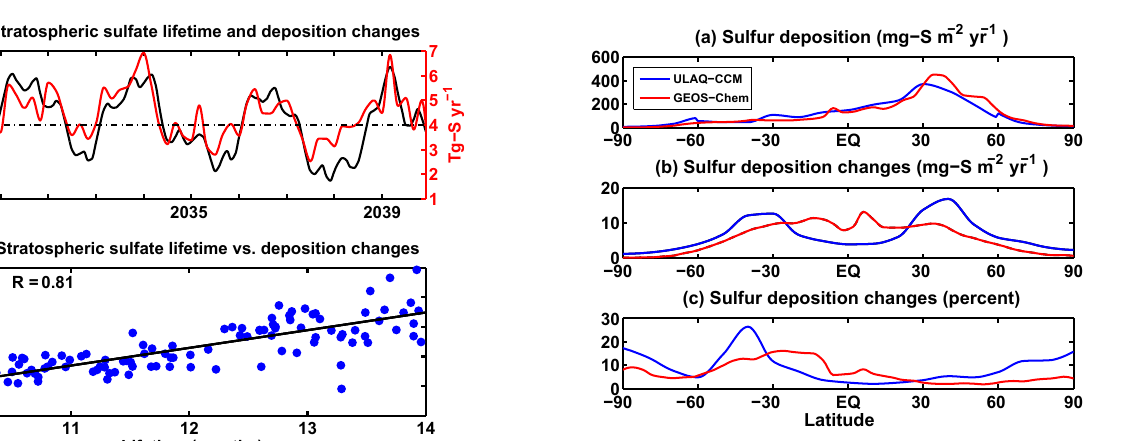
Figure 8. (a) Monthly means of geoengineering SO 4 lifetime (black; left scale; months) and sulfur deposition changes (G4-Base) (red; right scale; TgSyr − 1 ) for ULAQ-CCM (years 2030–2039). To highlight the correlation between the stratospheric SO 4 lifetime and the sulfate deposition, the monthly values of the latter have been treated as follows: (1) an annual mean cycle was first calculated over the whole decade; the annual variability was then removed, in order to keep the interannual variability alone; (2) detrended monthly de- position values were finally shifted ahead by 8 months. This latter value was chosen for optimizing the correlation and is close the av- erage time needed for G4 aerosols formed in the stratospheric tropi- cal pipe to reach the tropopause, where they are exchanged with the troposphere and finally lost by surface deposition. (b) Scatterplot of the values presented as time series in (a) (0.81 correlation coef- ficient). A comparable behavior is also found in the GEOS-Chem results (not shown), with a 0.92 correlation between monthly values of the stratospheric sulfate lifetime and detrended monthly deposi- tion values with 8 months’ lag.